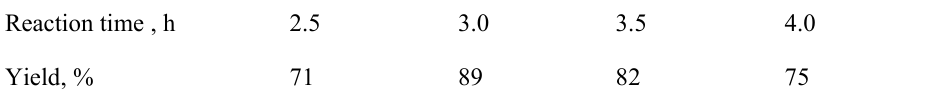
Table 3 The effect of reaction time on the oxidation of cyclohexanol to adipic acid under ultrasound